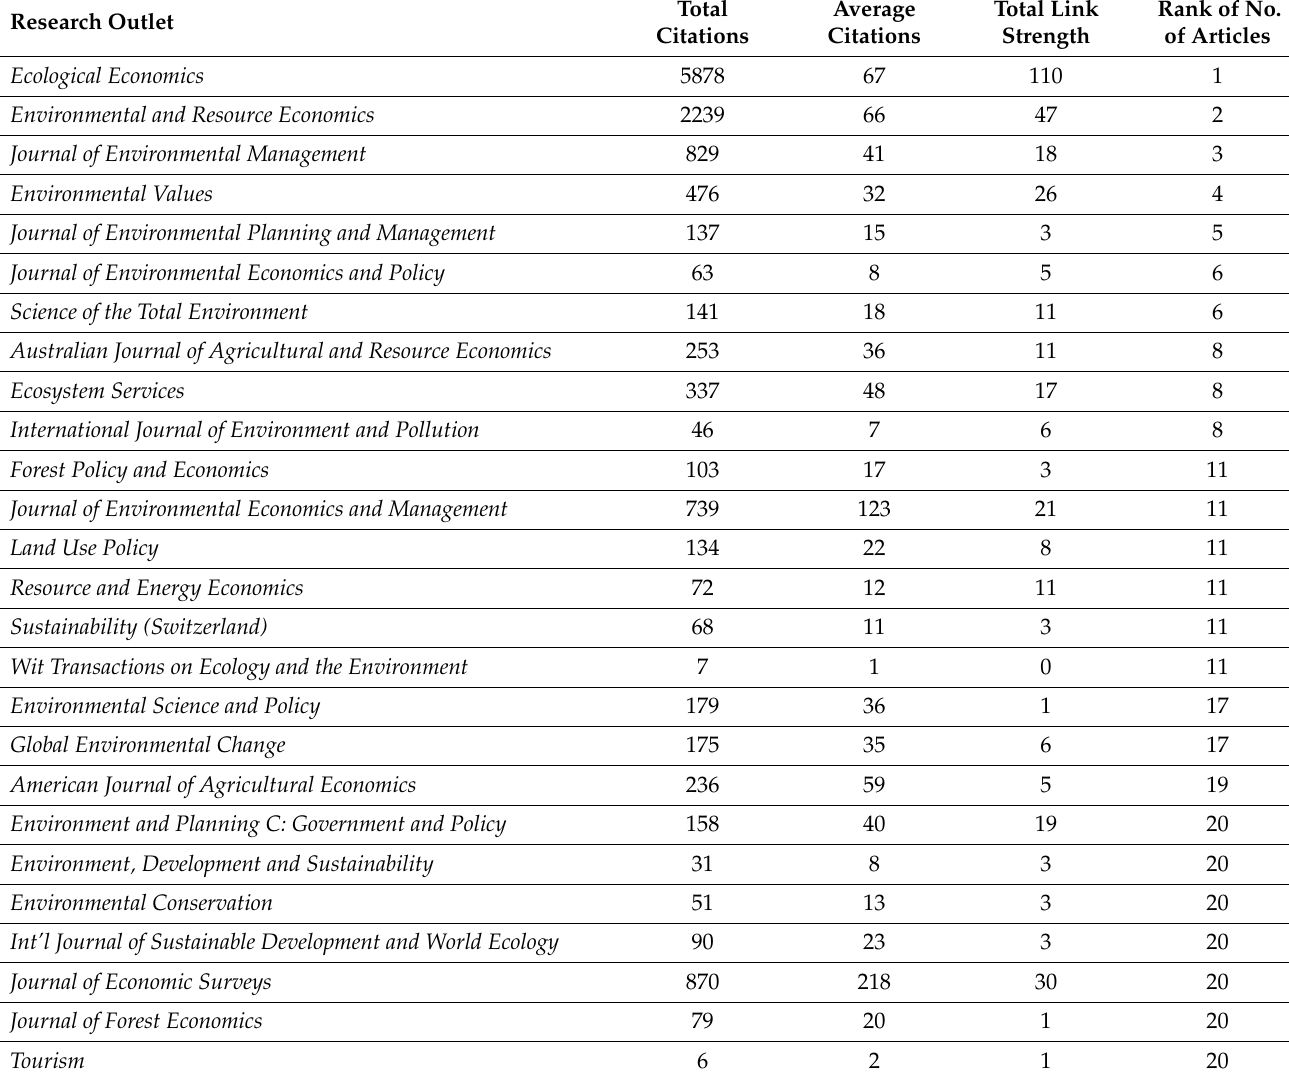
Table 3. Citations and strength of journal publications on environmental valuation